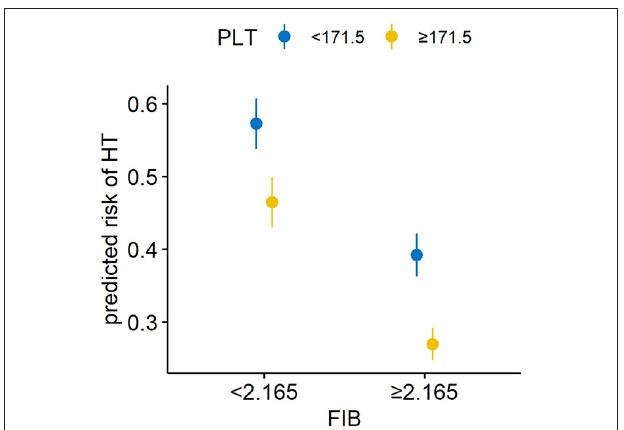
FIGURE 2 | Combined utility of the binary variates fibrinogen and platelets for predicting HT in AIS patients with MT. The combination of a fibrinogen level < 2.165 g/L and platelet count < 171.5 × 10 9 /L was the strongest predictor of HT. HT, hemorrhagic transformation; AIS, acute ischemic stroke; MT, mechanical thrombectomy; FIB, fibrinogen; PLT, platelets.